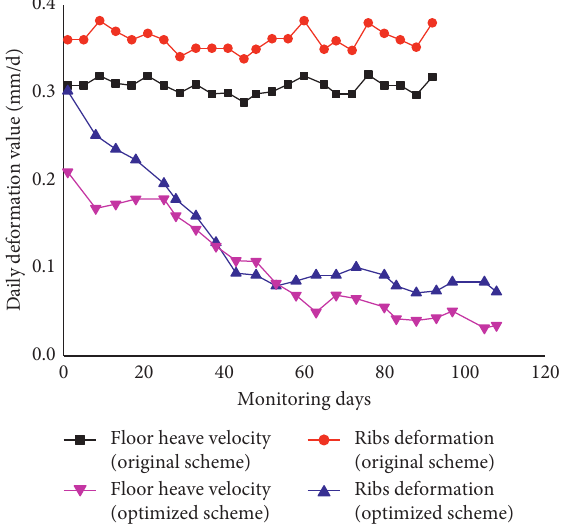
Figure 16: Comparison of approaching velocity of roadway sides and floor heave velocity before and after